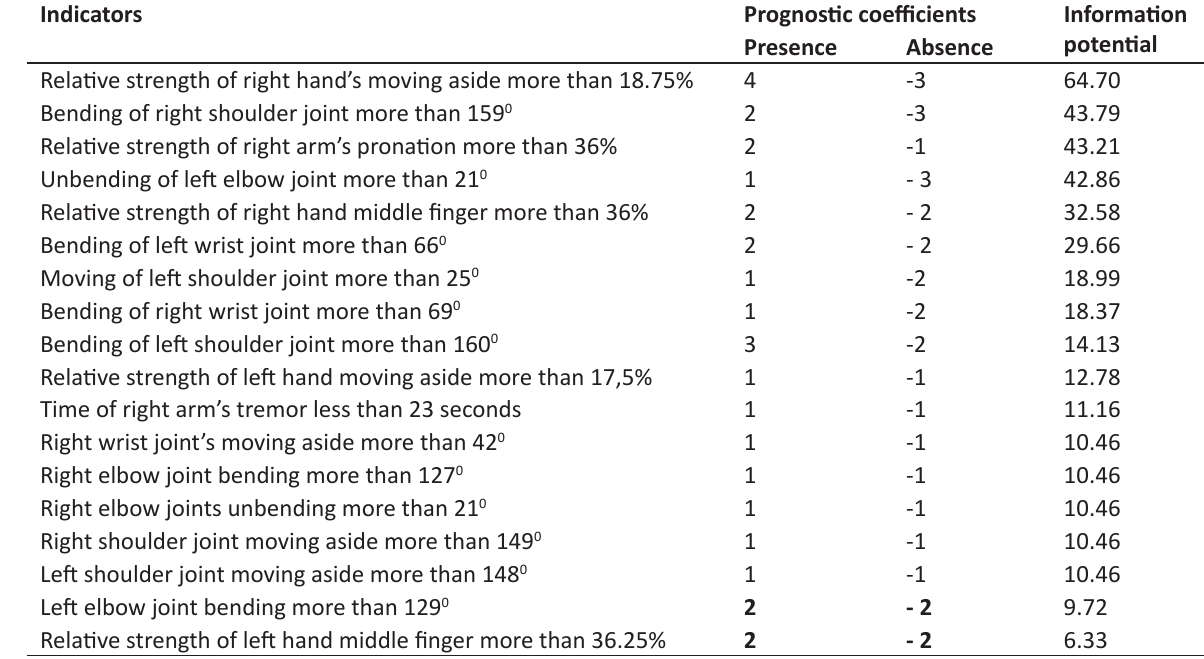
Table 1. Prognostication of arm wrestlers’ successfulness